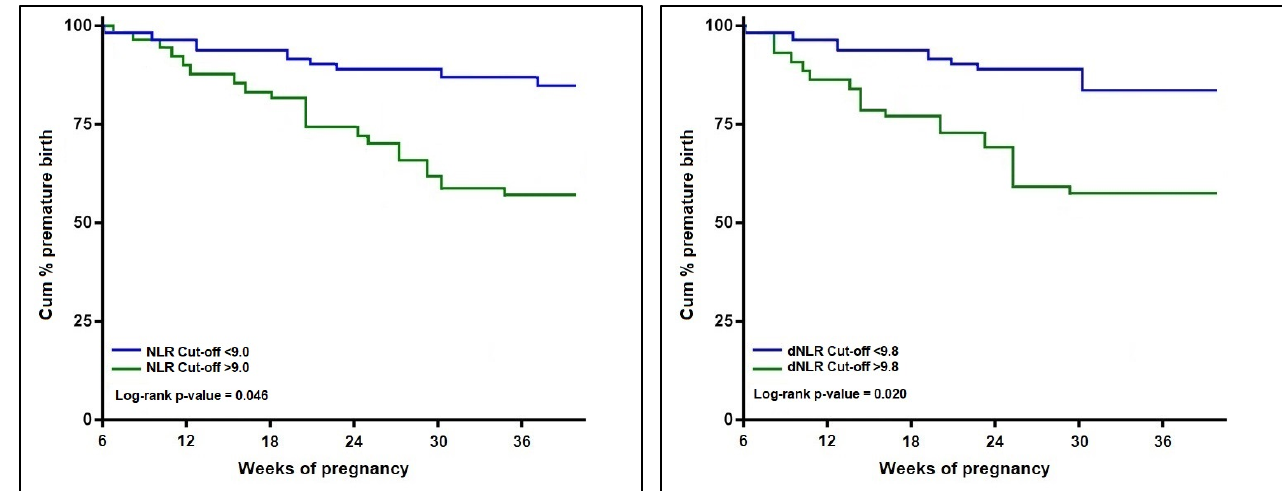
Figure 4. Kaplan–Meier probability analysis of premature birth by NLR and dNLR scores.